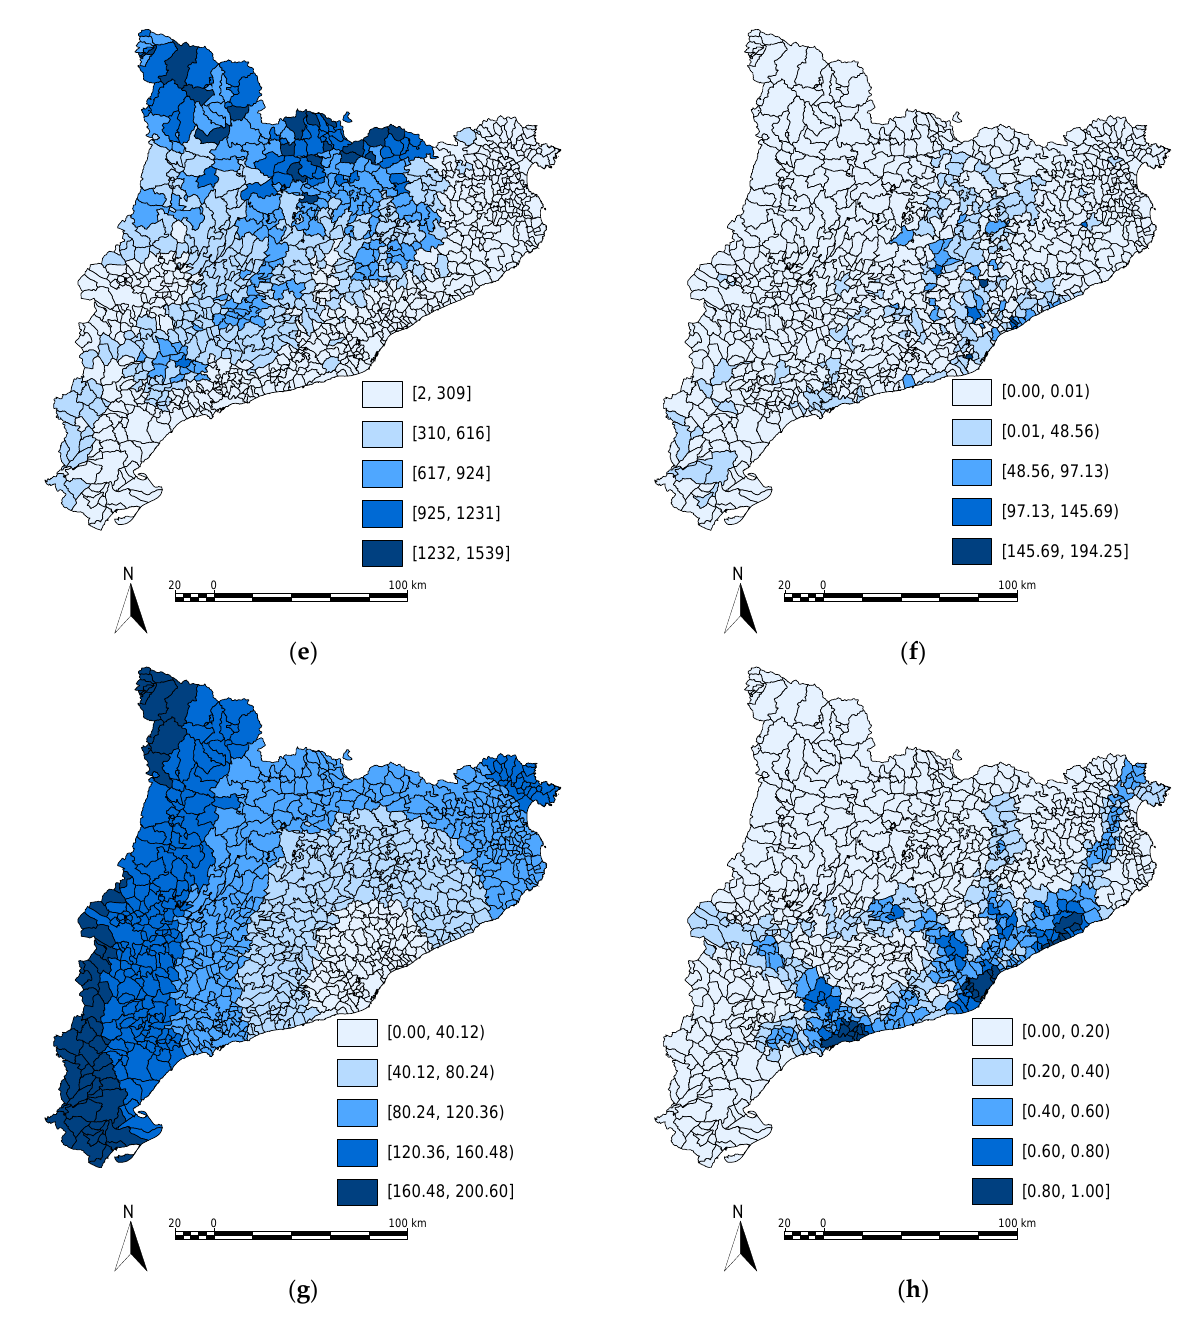
Figure 3. The main potential location factors in the Catalan pigmeat-processing industry in the second half of the 19th century by municipalities. Notes and sources: Authors’ own elaboration based on [46] for geographical information, [55] for data on livestock, [49,51,55,69 – 72] for the data used to estimate livestock densities, population, and, finally, georeferenced location, which refers to the distance between all the current Catalan municipalities and Barcelona. There is no information on the number of wool looms in the province of Lleida in 1861, where this activity was probably very limited [49,71]. See also text and Figure 1. ( a ) Pig density per area. Unit: Number of heads/Km2. ( b ) Pig density per population. Unit: Number of heads in 1865/1000 inhabitants in 1861. ( c ) Demographic trends. Unit: Population ratio 1900/1857. ( d ) Textile industry trends. Unit: Cotton loom proportion variation 1861/1931. ( e ) Altitude. Unit: Metres. ( f ) Textile industry activity. Unit: No. of cotton and wool Looms/1000 inhabitants in 1861. ( g ) Distance from Barcelona. Unit: Kilometres. ( h ) Railway accessibility. Unit: Distance gradient to closest train stations before 1891.